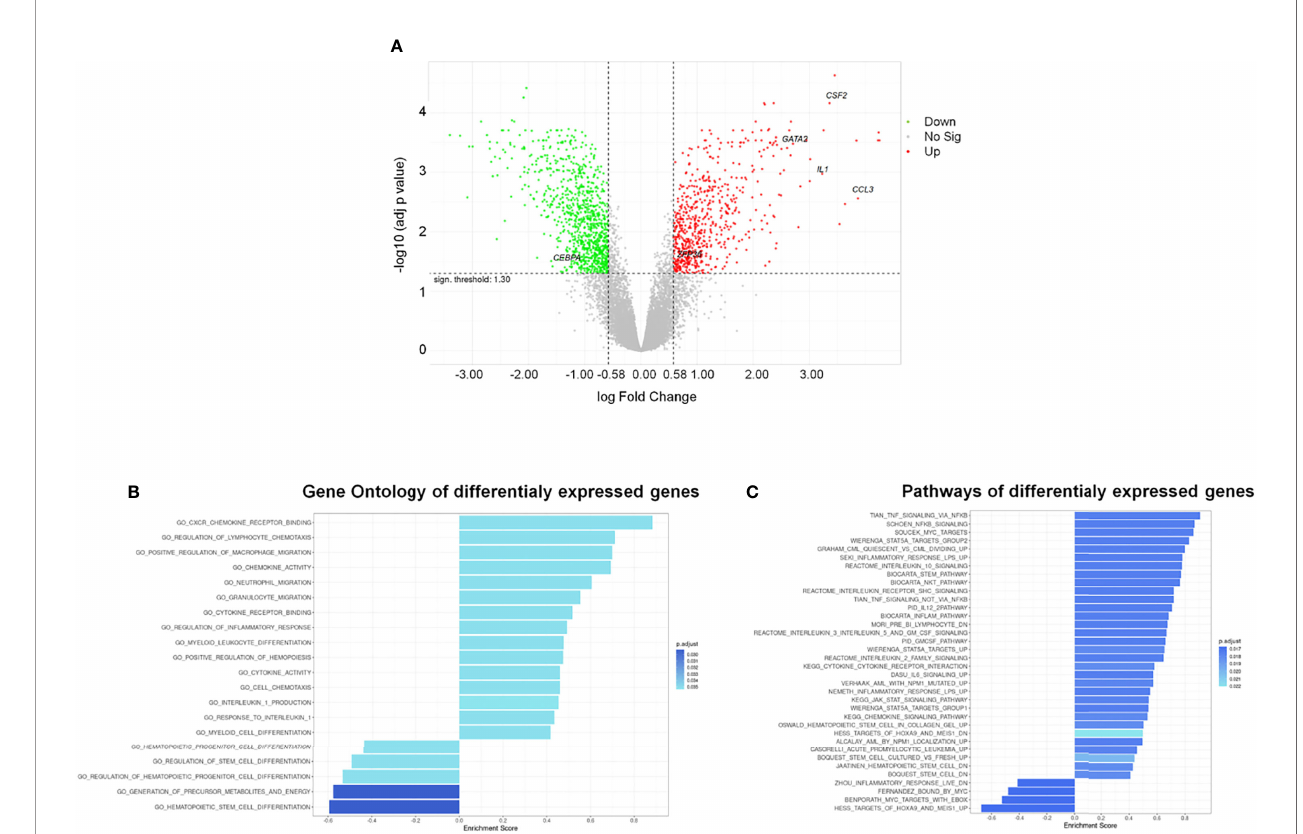
FIGURE 4 | Differentially Expressed Genes (DEGs) and functional analysis of HSPCs treated with AML-EVs. (A) Volcano plot of all genes resulting from Gene Expression Pro fi le (GEP) analysis in HSPCs treated with KG-1 EVs vs untreated cells; the x-axis represents the log fold-change value and y axis represents the statistical signi fi cance; the horizontal line indicates the signi fi cant threshold of DEG; the vertical lines represent the threshold of log fold change ≥ |0.58|; the labeled dots represent selected genes of interest. Signi fi cantly up- and down-regulated genes are highlighted in red and green, respectively. Gene ontology (B) and pathway (C) enrichment analysis performed on up- and down-regulated gene sets of HSPCs treated with AML-EVs. Left and right direction of bars represents down- and up- regulated gene sets,